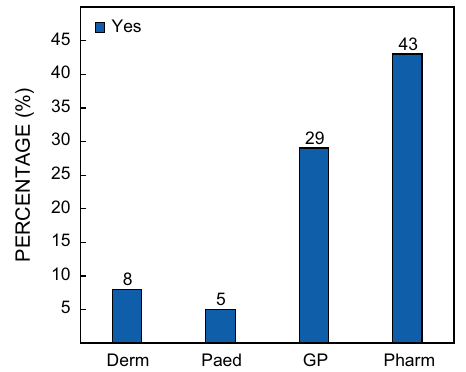
Table 3: South African healthcare professionals’ practices regarding CAM Statement